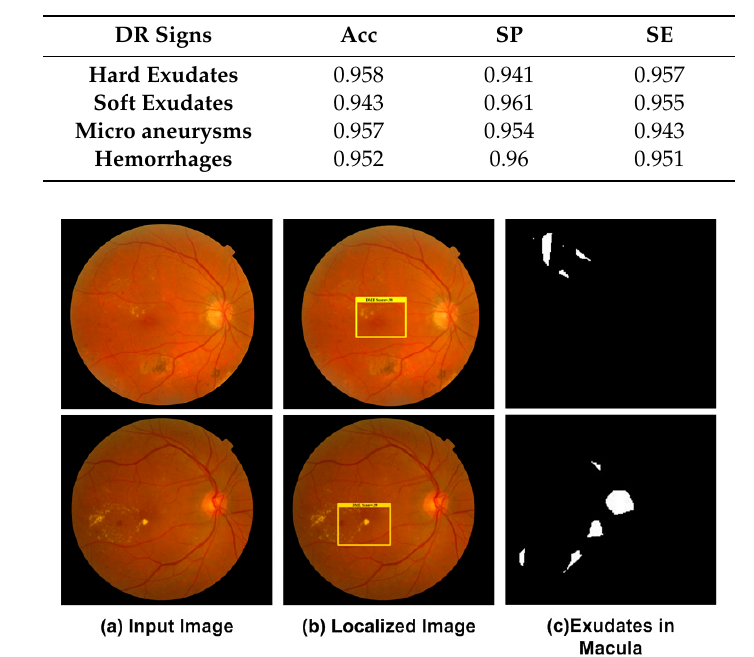
Figure 6. Segmentation results of DR signs.